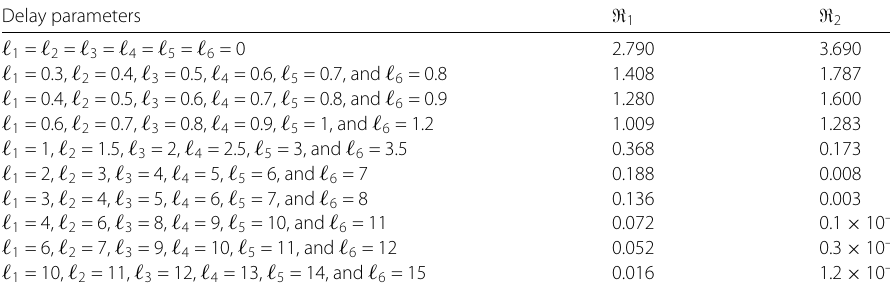
Table 2 The variation of (cid:9) 1 and (cid:9) 2 with respect to the delay parameters Delay parameters (cid:9)